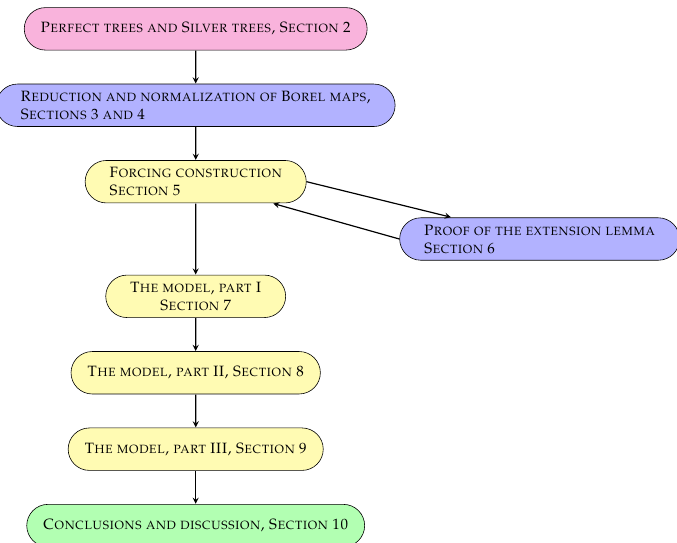
Figure 1. Flowchart of the proof of Theorem